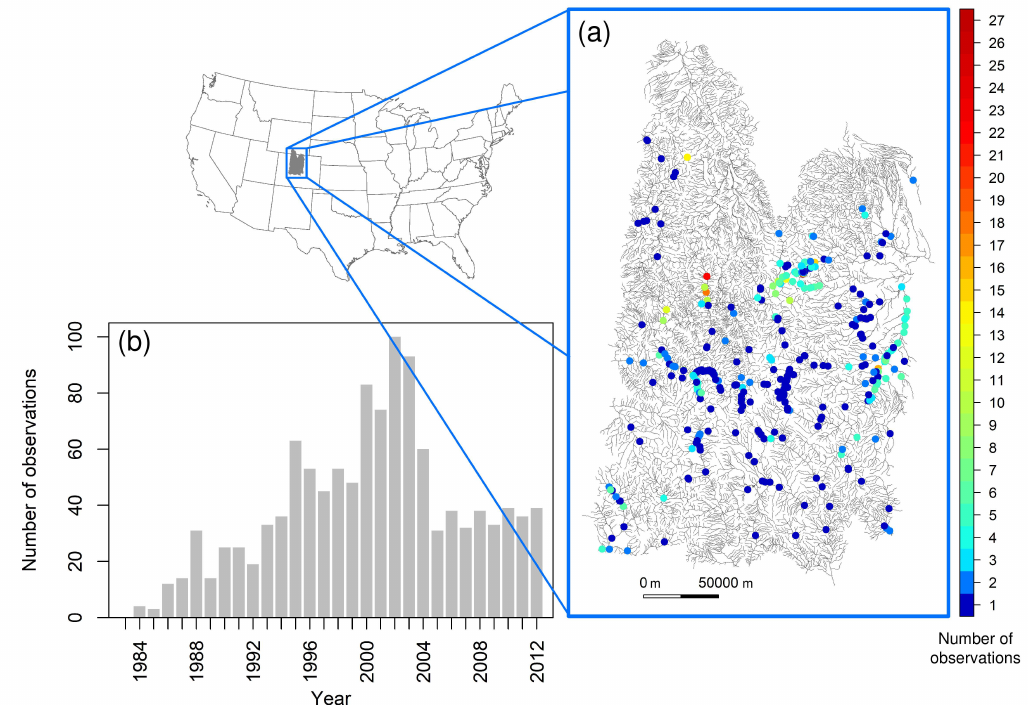
Figure 1. Study area located in the section of the Rocky Mountains that has been affected by anthropogenic and natural disturbances in the 1983–2012 period ( a ), and number of observations available per year once the dissolved organic matter (DOM) data have been transformed to yearly averages for the corresponding base-flow periods as described in Section 2.2 ( b ). In ( a ), the stream network is represented by the gray line segments, and the 371 points in the stream network represent the locations with DOM measurements. The color scale represents the number of observations as in ( b ) but at each location. Basins located near the northeast corner of the study area are not included due to a lack of